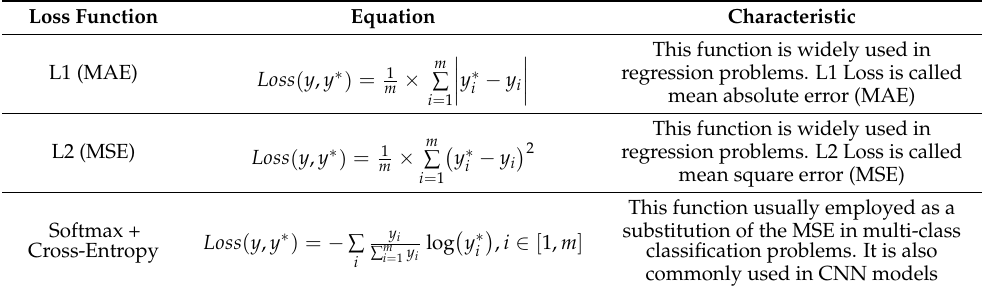
Table 1. Common loss functions for CNN models.